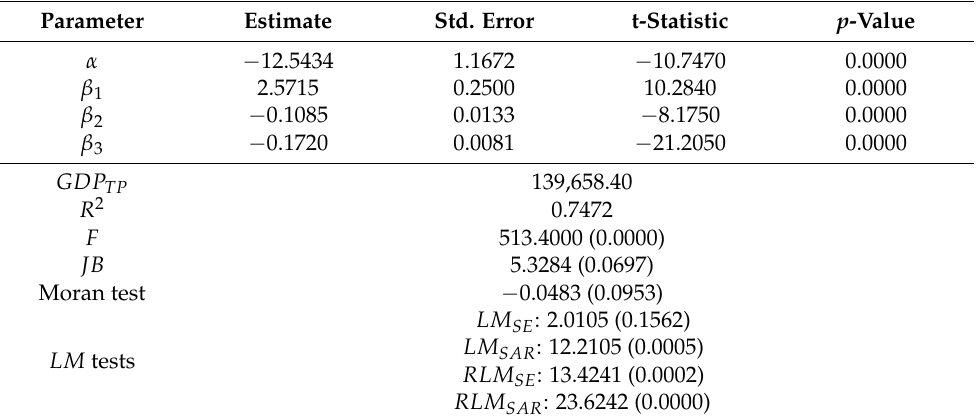
Table 2. The results of estimation and verification of the TSCS model for the squared Kuznets curve.